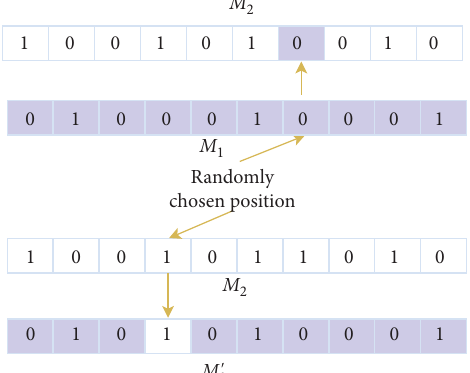
Figure 7: Illustration of intermolecular inefective